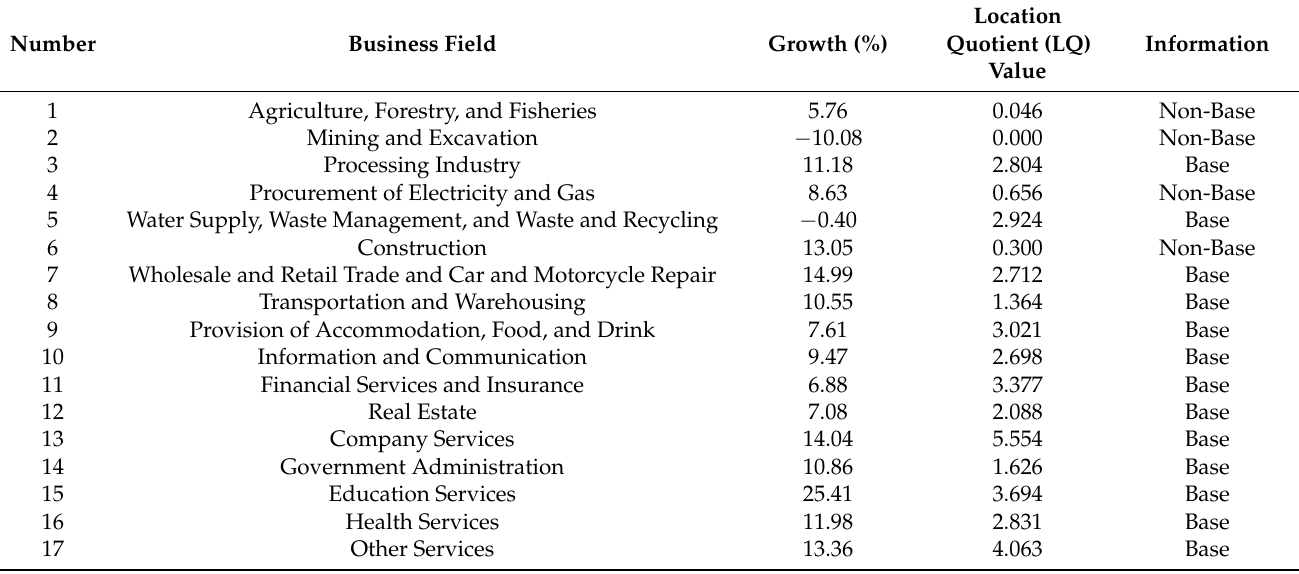
Table 3. The basic and non-basic economic sectors of Makassar City.